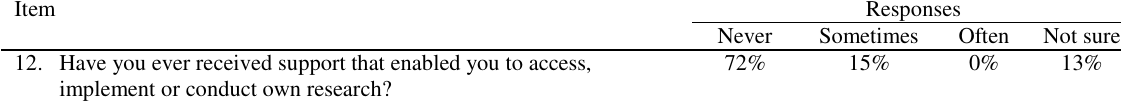
Table 4 Crosstabs on the themes access to, implementation of, and conduct of research